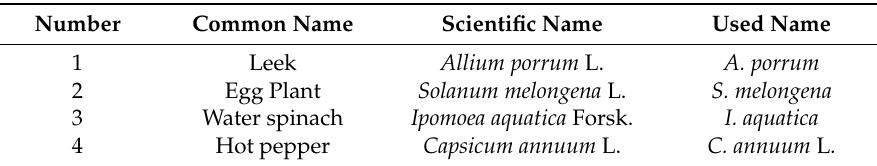
Table 1. Selected plant species for